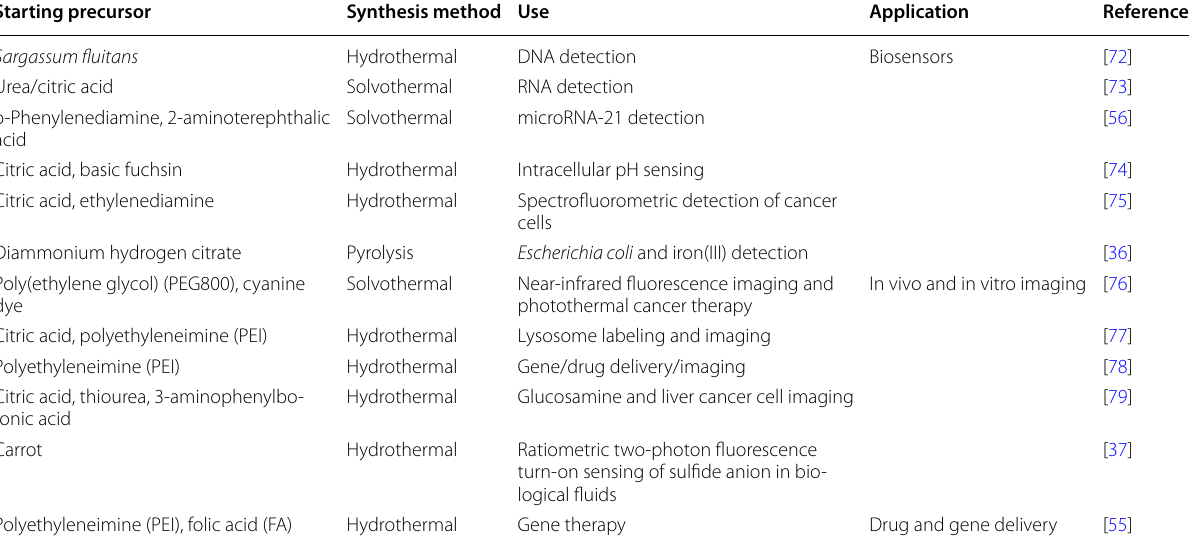
Table 2 Biomedical applications Starting